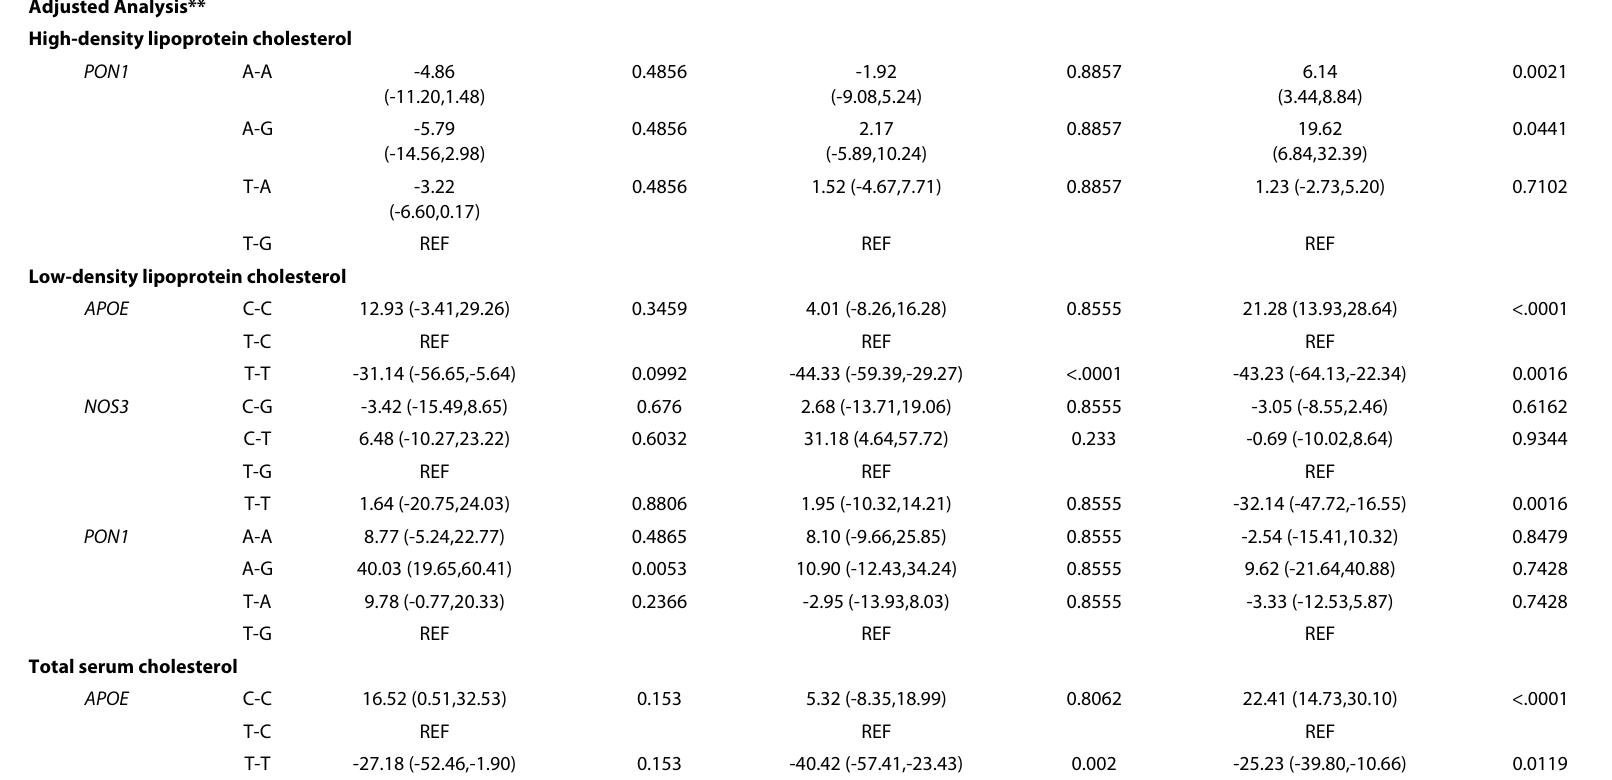
Table 3: Crude and adjusted haplotype analysis for blood lipid levels by race/ethnicity - NHANES III (1991-1994)